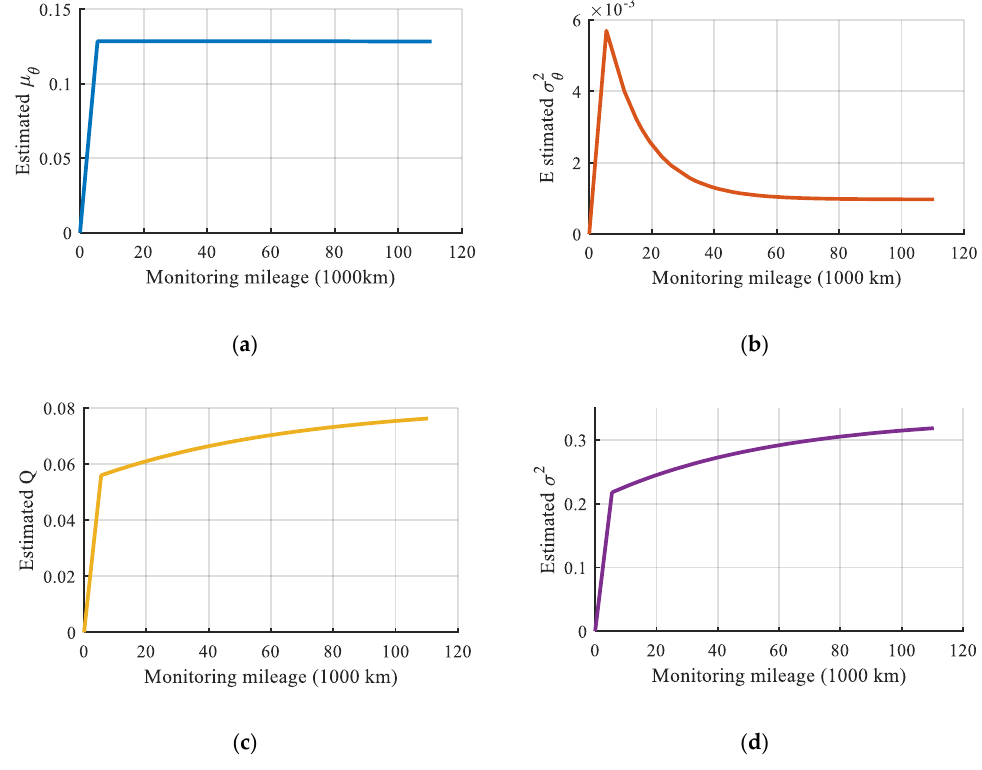
Figure 15. Results of model parameter estimation, ( a ) the restoration results of estimated μ θ ; ( b ) the restoration results of estimated σ 2 θ ; ( c ) the restoration results of estimated Q; ( d ) the restoration results of estimated σ 2 .